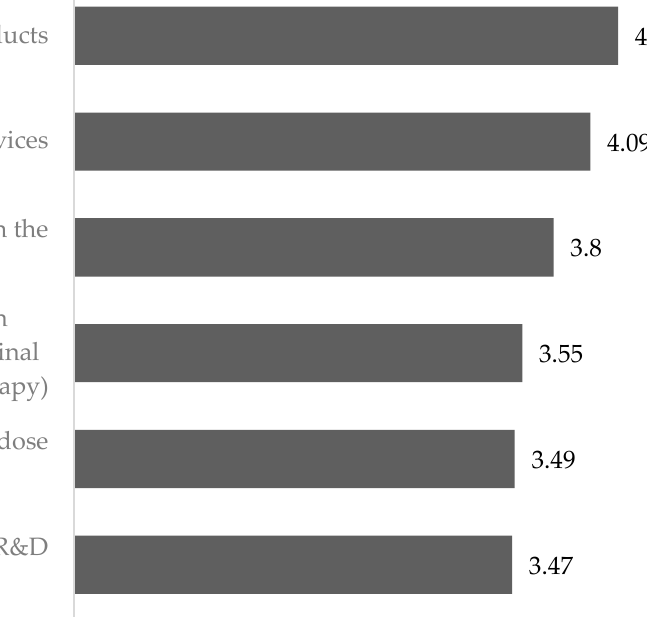
Figure 4. Assessment of the need to introduce changes in the area of research and development— mean.